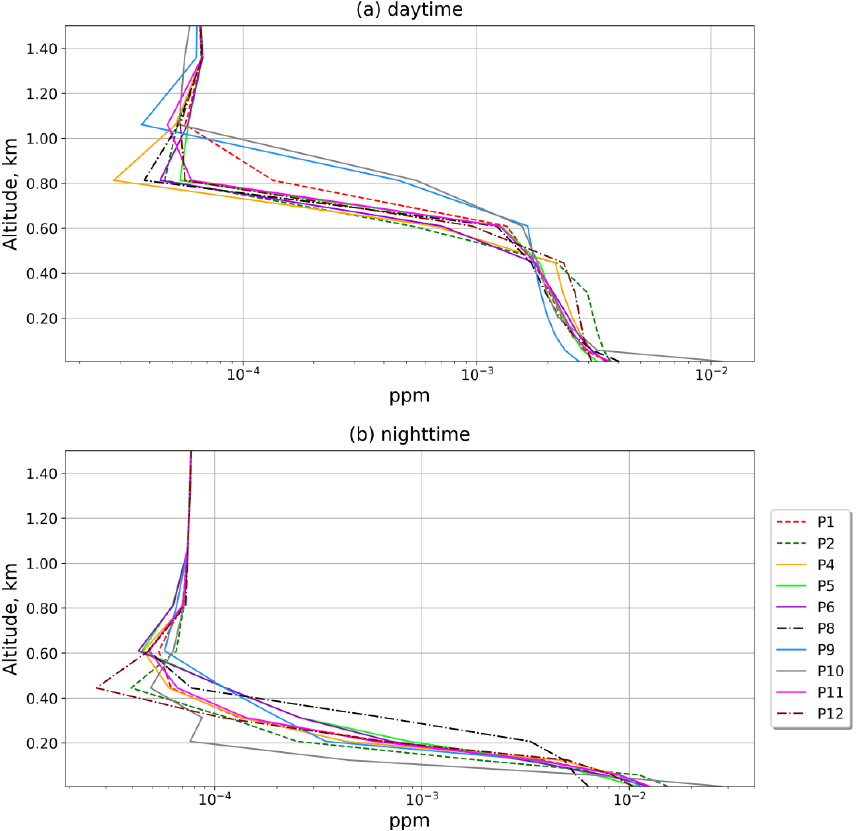
Figure 11. Average NO 2 vertical profile over the APEX region, shown for all sensitivity simulations below 1.4km altitude (a) at 13:30UT on 27 June and (b) at 01:30UT on 28 June. Above 1.4km, the differences between model sensitivity runs are